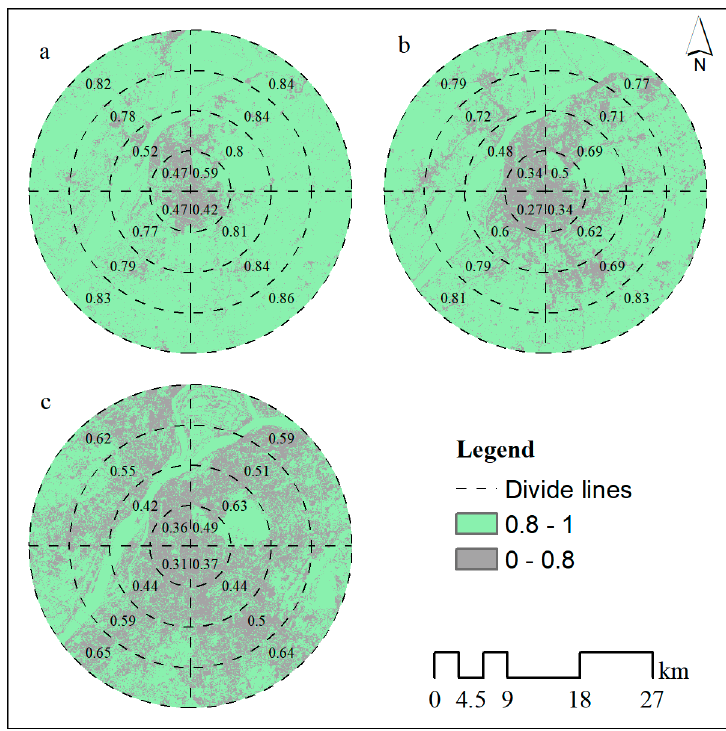
Figure 6. The spatial distribution of 𝑉𝐶𝑅𝑎 ‐ 𝐿 on the city ‐ level of Nanjing in (a) 1985, (b) 2000, and (c) 2015. The composite 𝑉𝐶𝑅𝑎 ‐ 𝐿 for the concentric pie zones was annotated by text.